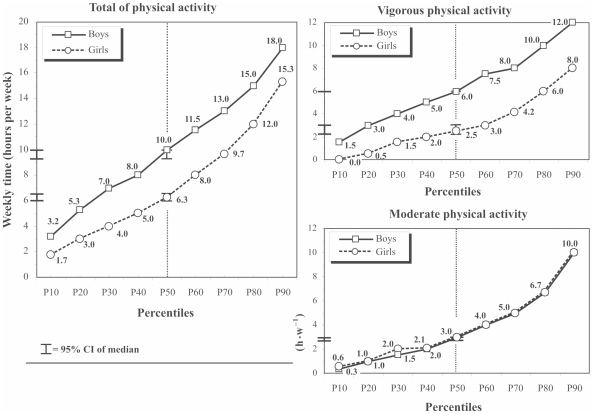
Percentiles of time dedicated to moderate, vigorous and total of physical activities among adolescents participants.